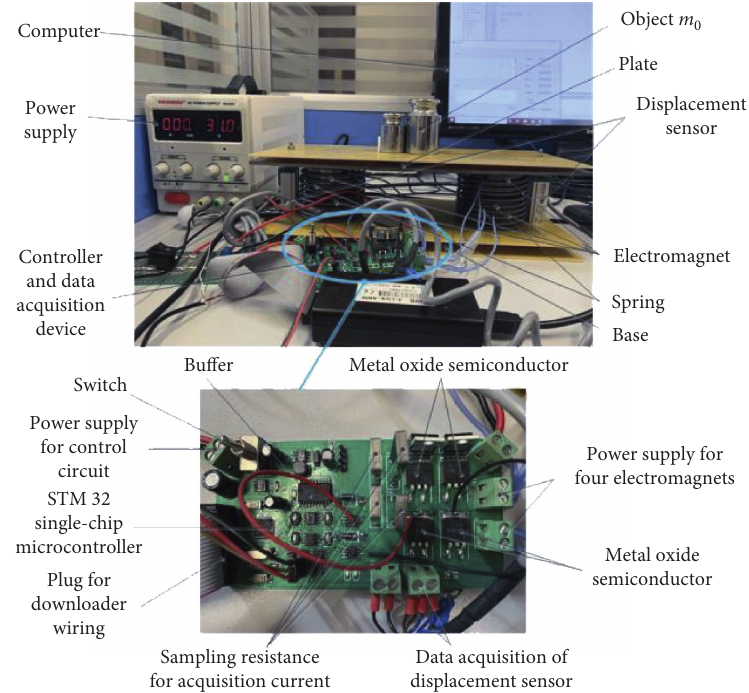
Figure 8: The experimental physical